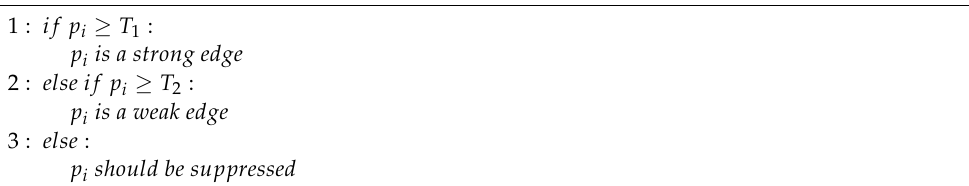
Algorithm 1 Traditional double threshold extraction